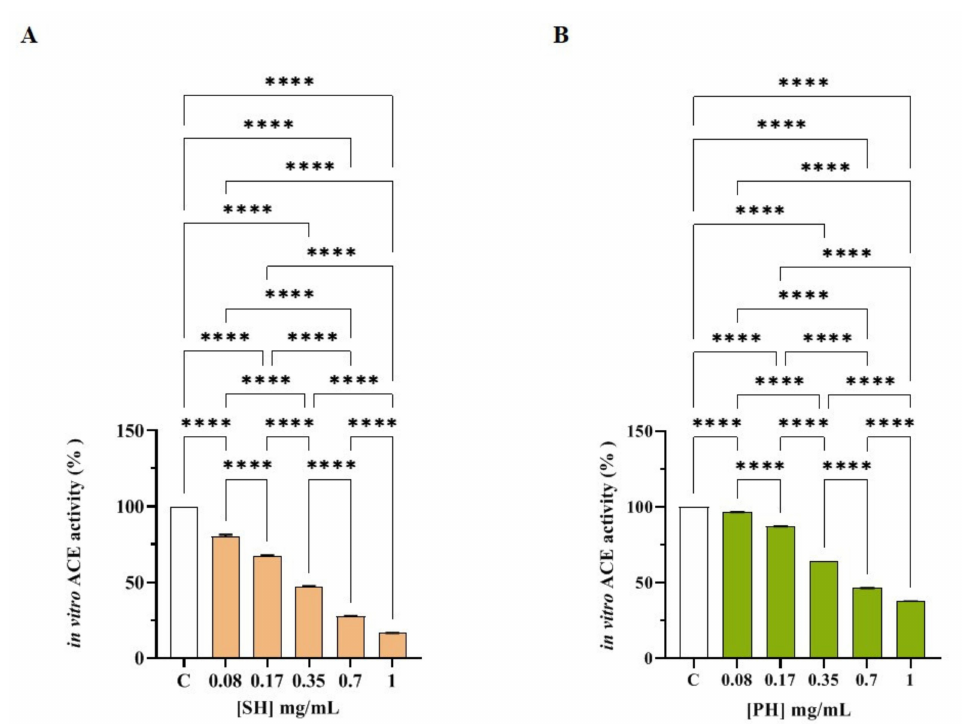
Figure 3. Assessment of the in vitro ACE-inhibitory effects of SH ( A ) and PH ( B ) hydrolysates. Bars represent the sd of three independent experiments in duplicate. **** p < 0.0001 versus control sample (C).